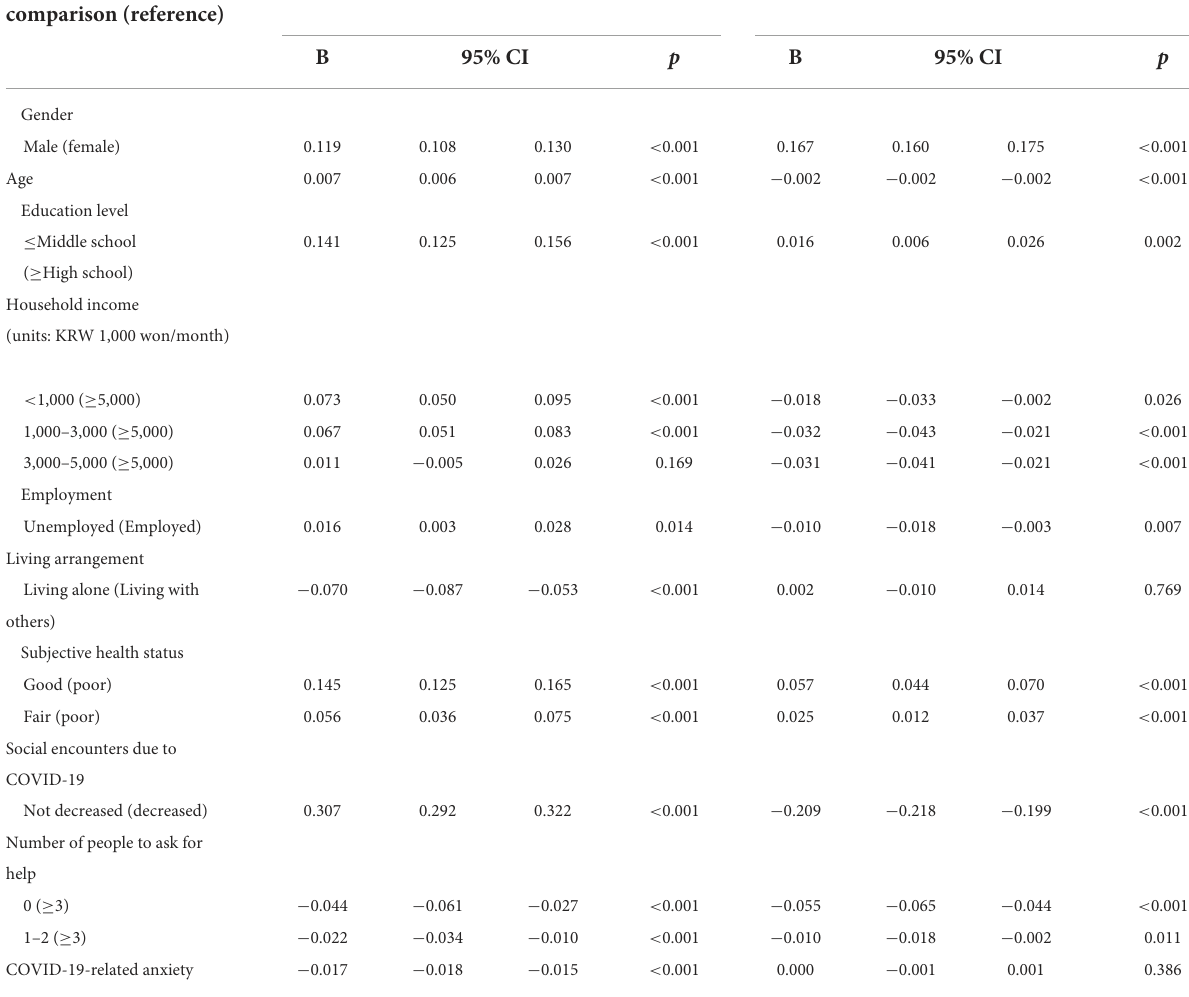
TABLE 4 Factors influencing the healthy behavioral change index and addictive behavioral change